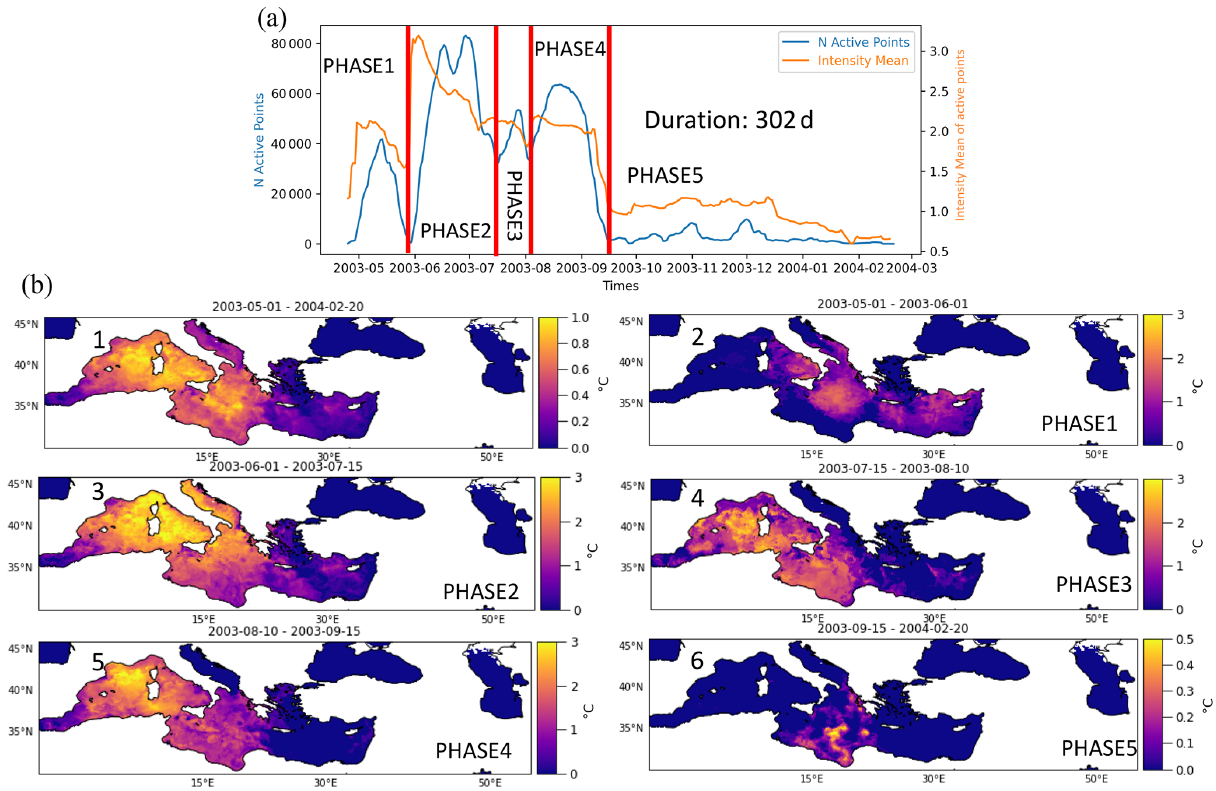
Figure 8. (a) Active points, i.e., points which simultaneously experienced the labeled MED-MHW-2003 (blue line) and mean intensity of the active points (orange) during the 2003 MHW. (b) Average of the mean intensities during the MED-MHW-2003 period (1) and during its phases (2, 3, 4, 5, and 6) computed as the sum of the MHW daily intensities divided by the duration of the